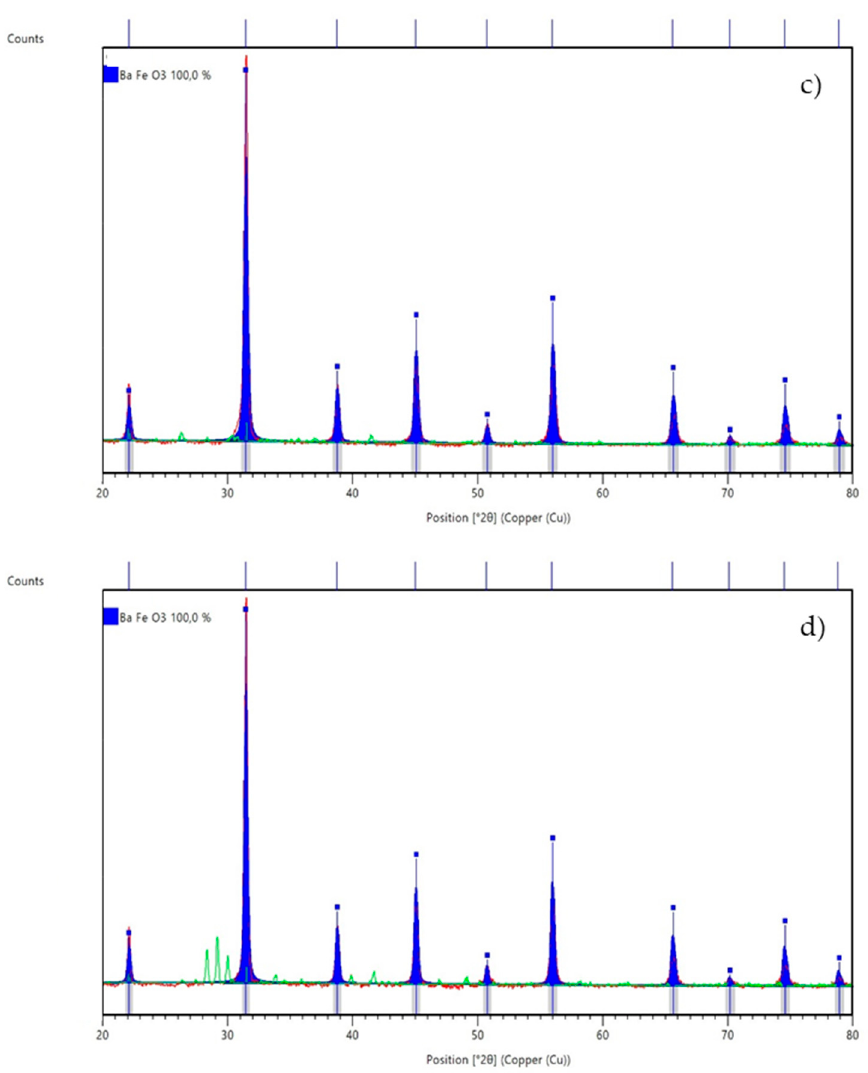
Figure 2. Rietveld analysis for (minority phase not included in the analysis): ( a ) BFC0: in red the original XRD pattern, in blue the Rietveld simulation corresponding to hexagonal perovskite structure and in green the residual data corresponding to triclinic structure; ( b ) BFC1: in red the original XRD pattern, in blue the Rietveld simulation corresponding to hexagonal perovskite structure and in green the residual data corresponding to triclinic structure; ( c ) BFC3: in red the original XRD pattern, in blue the Rietveld simulation corresponding to cubic perovskite structure and in green the residual data corresponding to BaCuO 2 ; ( d ) BFC4: in red the original XRD pattern, in blue the Rietveld simulation corresponding to cubic perovskite structure and in green the residual data corresponding to BaCuO 2 .